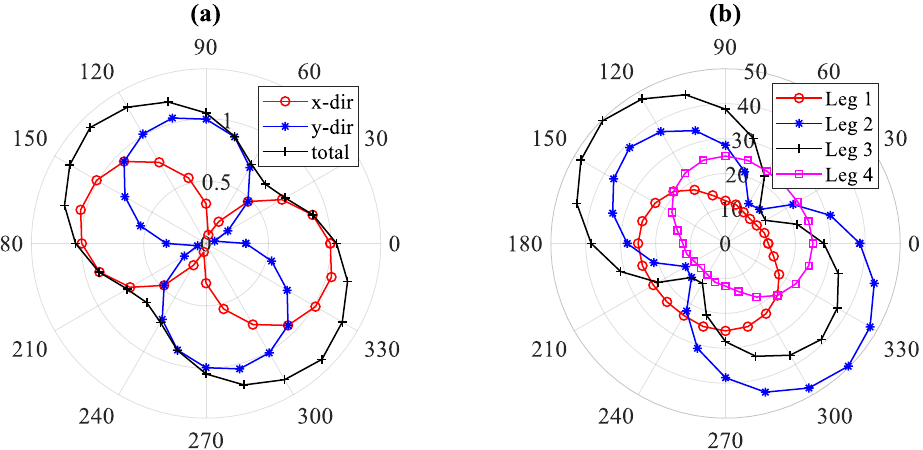
Figure 7. Polar diagrams under Env loads: ( a ) displacements at IP (cm); ( b ) stresses at lower jacket legs (MPa).